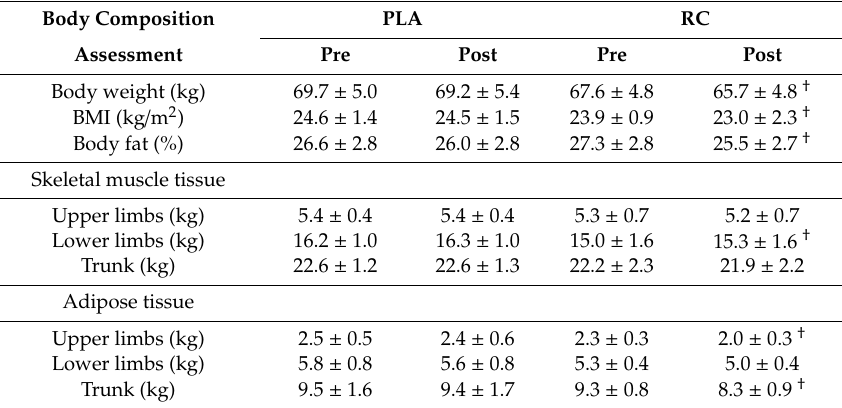
Table 3. Body composition